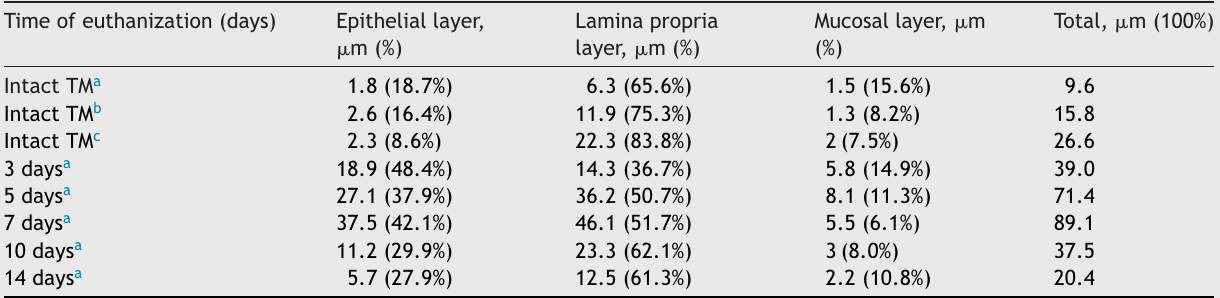
Table 1 Mean thickness of the epithelial, lamina propria and mucosal layers; and total thickness of the tympanic membrane (TM) throughout the study on days 0 (intact TM), 3, 5, 7, 10 and 14. Time of euthanization (days) Epithelial layer, (cid:2) m (%)